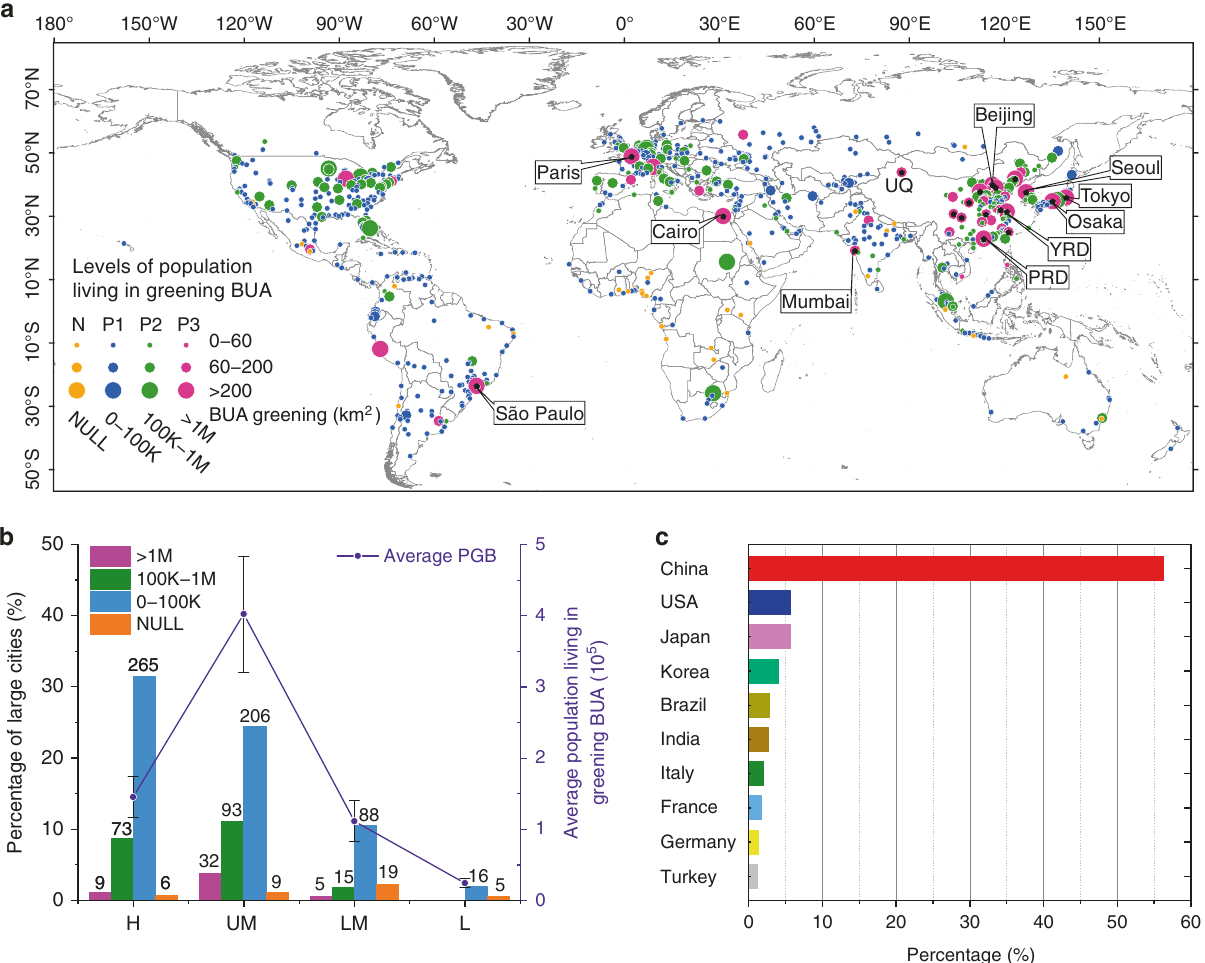
Fig. 4 Distribution of the population living in greening built-up area (BUA). a Distribution of the 841 large cities at different levels of population living in greening BUA (noted as PGB). N: No PGB; P1: 0 < PGB ≤ 100K, blue points; P2: 100K < PGB ≤ 1M, green points; P3: PGB > 1M, magenta points. The top 20 PBG large cities are marked with black dots, and 10 of them are labeled with their names (see Supplementary Table 2 for details). YRD Yangtze River Delta, PRD Pearl River Delta, UQ Urumqi. b Bars are the percentages of the total 841 large cities for PGB at four economic levels. Purple lines are the average PGB at four economic levels. Error bars show SEM for each economic level. c The top 10 countries with largest percentages of the total PGB in the 841 large